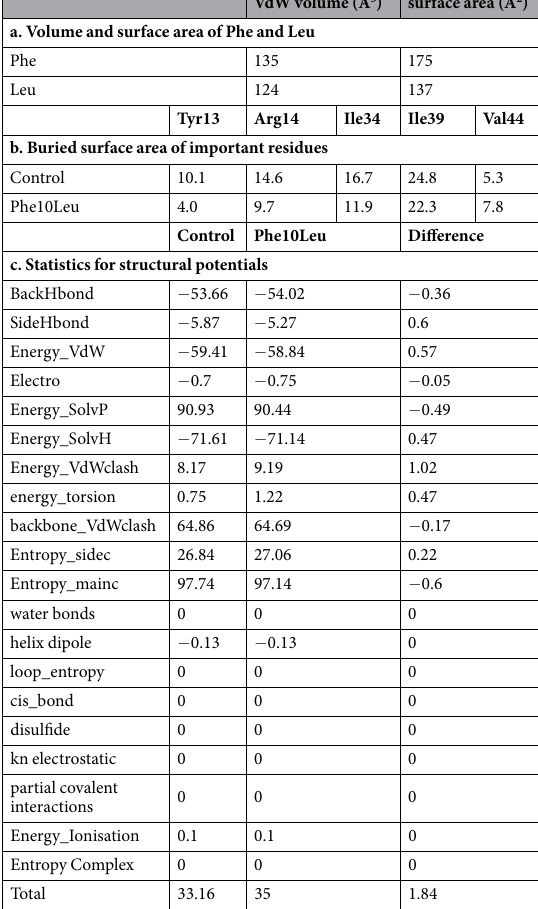
Table 2. Results of structural